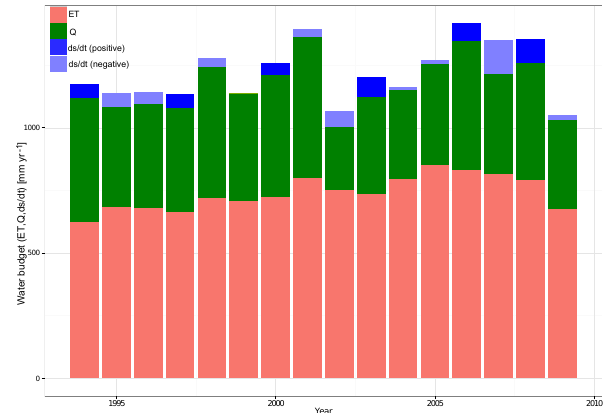
Figure 9. Water-budget components of the basin and its annual vari- abilities from 1994 to 2009. The relative share of each of the three components ( Q , ET, and d s / d t ) of the total available water J is represented by the length of the bars (NB the total length of the bar minus the negative storage is J ). The positive and negative storage of the years are shown by dark blue and light blue respectively.